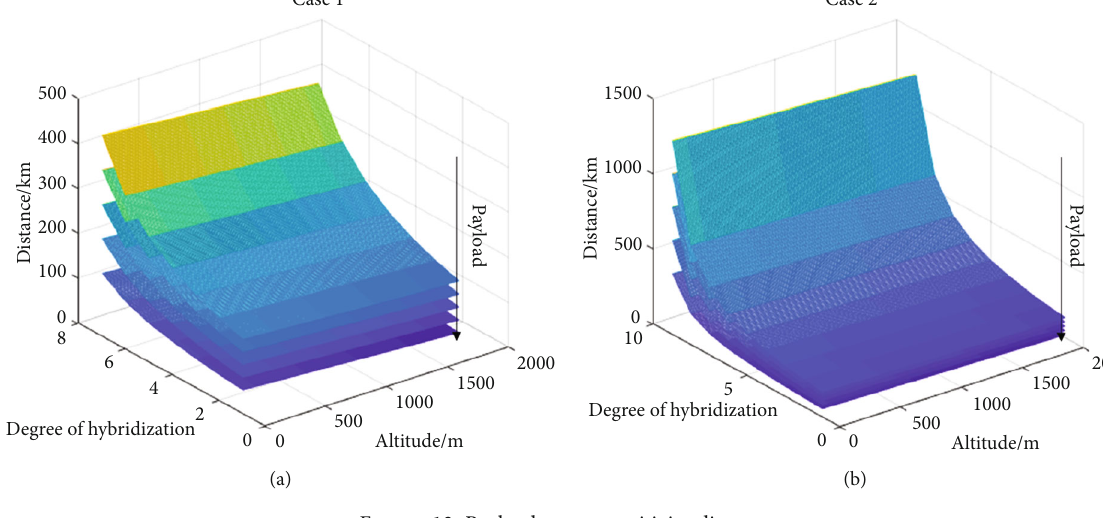
Figure 12: Payload-range sensitivity